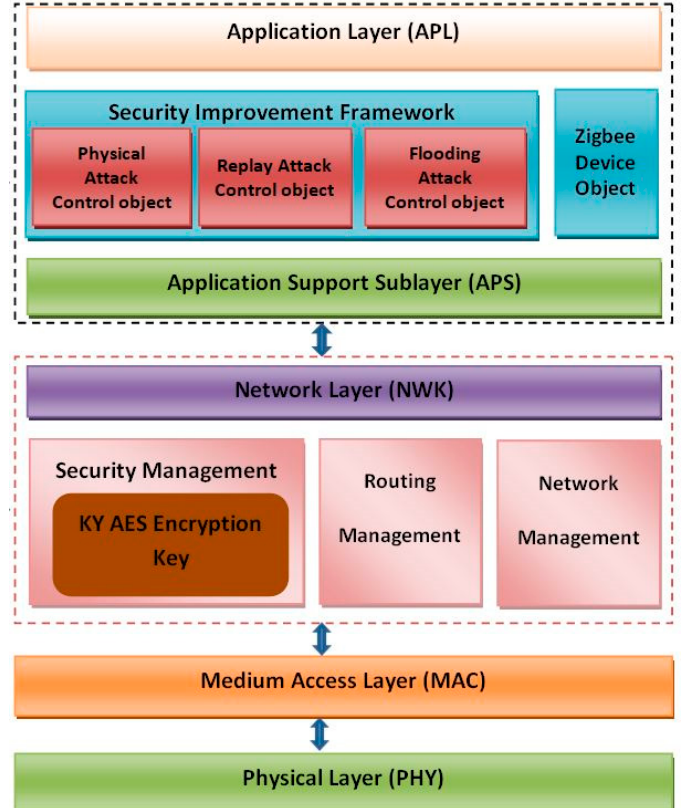
Figure 3. Proposed Security Improvement Framework (SIF) of Zigbee network in the IoT platform.